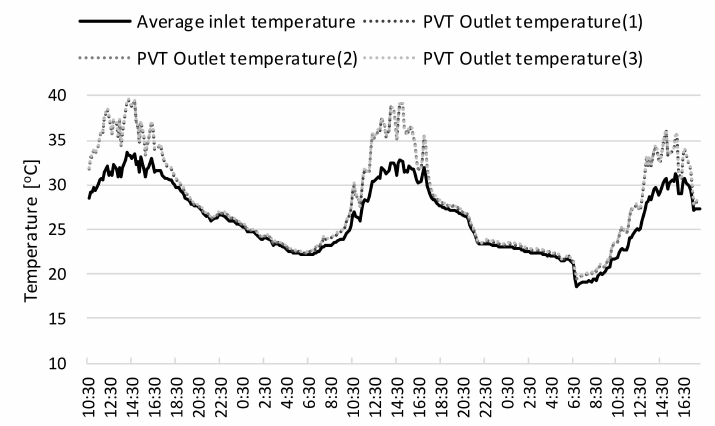
Figure 7. Outlet temperatures of the PVT